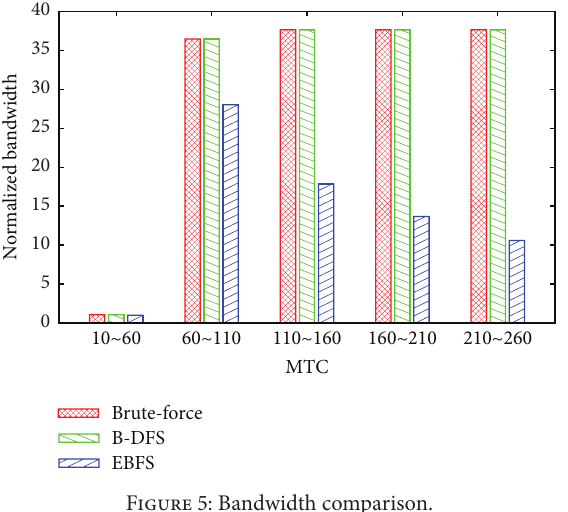
Figure 5: Bandwidth comparison. Table 2: The average number of BAG and MTU pairs per VL. MTC